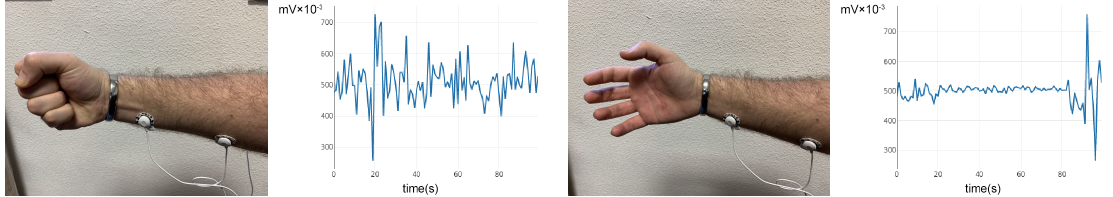
Figure 2. Two samples of hand poses and the corresponding sEMG profile, as provided by the BITalino controller. The X-axis shows the time, measured in seconds, and the Y-axis shows the muscle activity, measured in mV × 10 − 3